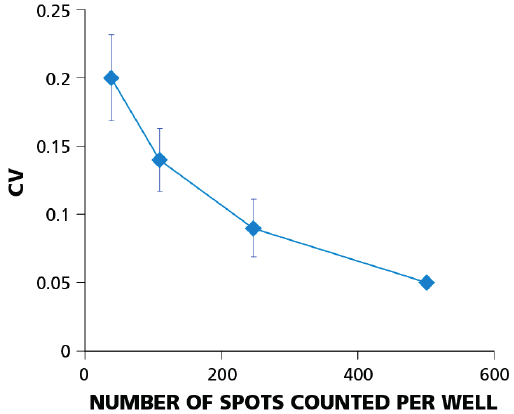
Figure 6. The relative experimental error (coefficient of variation, CV) decreases with increasing number of spot counts per well. Testing PBMC at higher cell numbers helps establish positivity when statistical analysis is at the limit of confidence. CV data were obtained from eight independent experiments using a single donor with a dominant CD8+ T-cell IFN- γ response to EBV peptide LMP2A (426–434). Error bars show ± σ between individual experiments. In individual experiments, CVs were calculated for each of four cell dilutions (5 × 10 4 ; 1 × 10 5 ; 2 × 10 5 ; 4 × 10 5 ) using 12 replicate wells for each